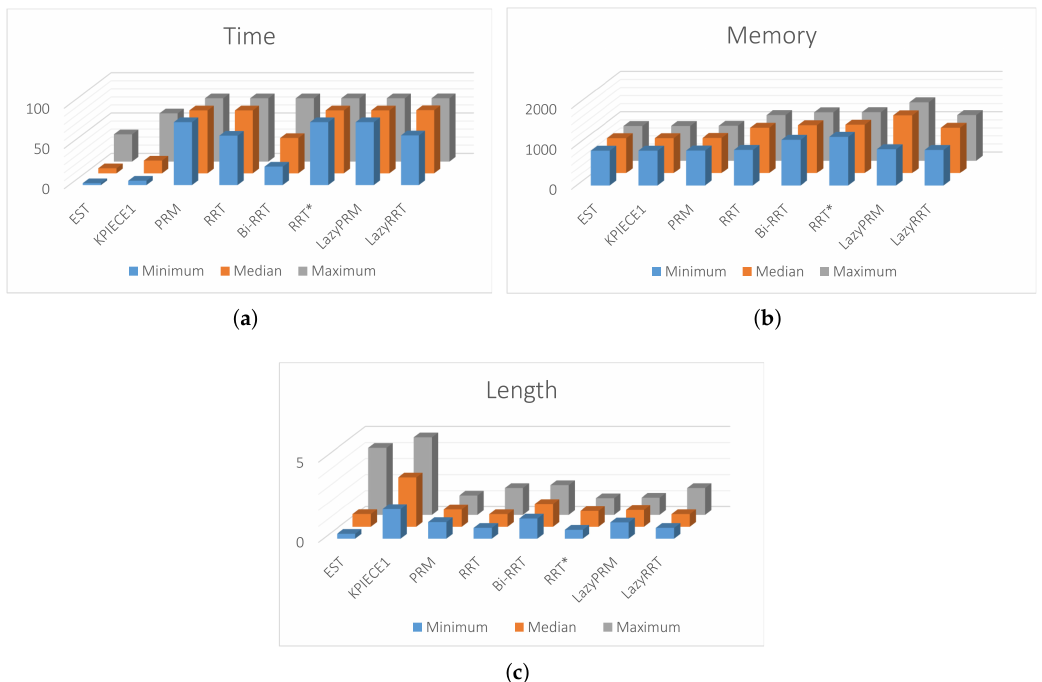
Figure 33. Bar graphs for time, length of path, and memory in number of times respect to the MGHPPM results of case 4. ( a ) Execution time. ( b ) Memory. ( c ) Length of